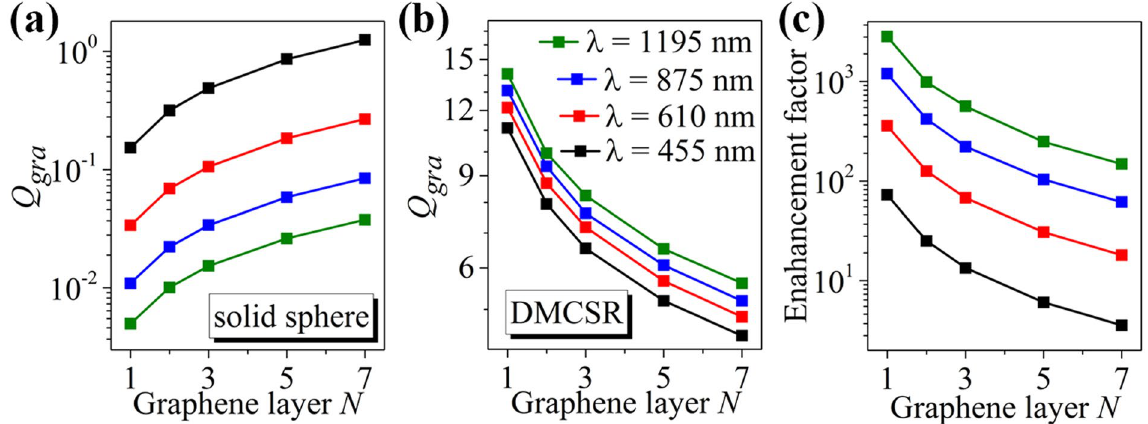
Figure 6. Maximum achievable graphene absorption efficiencies for the solid silver nanospheres ( a ) and the DMCSRs ( b ) wrapped by graphene with different layers at four different wavelengths of λ = 455 nm, 610 nm, 875 nm, and 1195 nm. ( c ) Enhancement factors of the graphene absorption efficiencies at the wavelengths of λ = 455 nm, 610 nm, 875 nm, and 1195